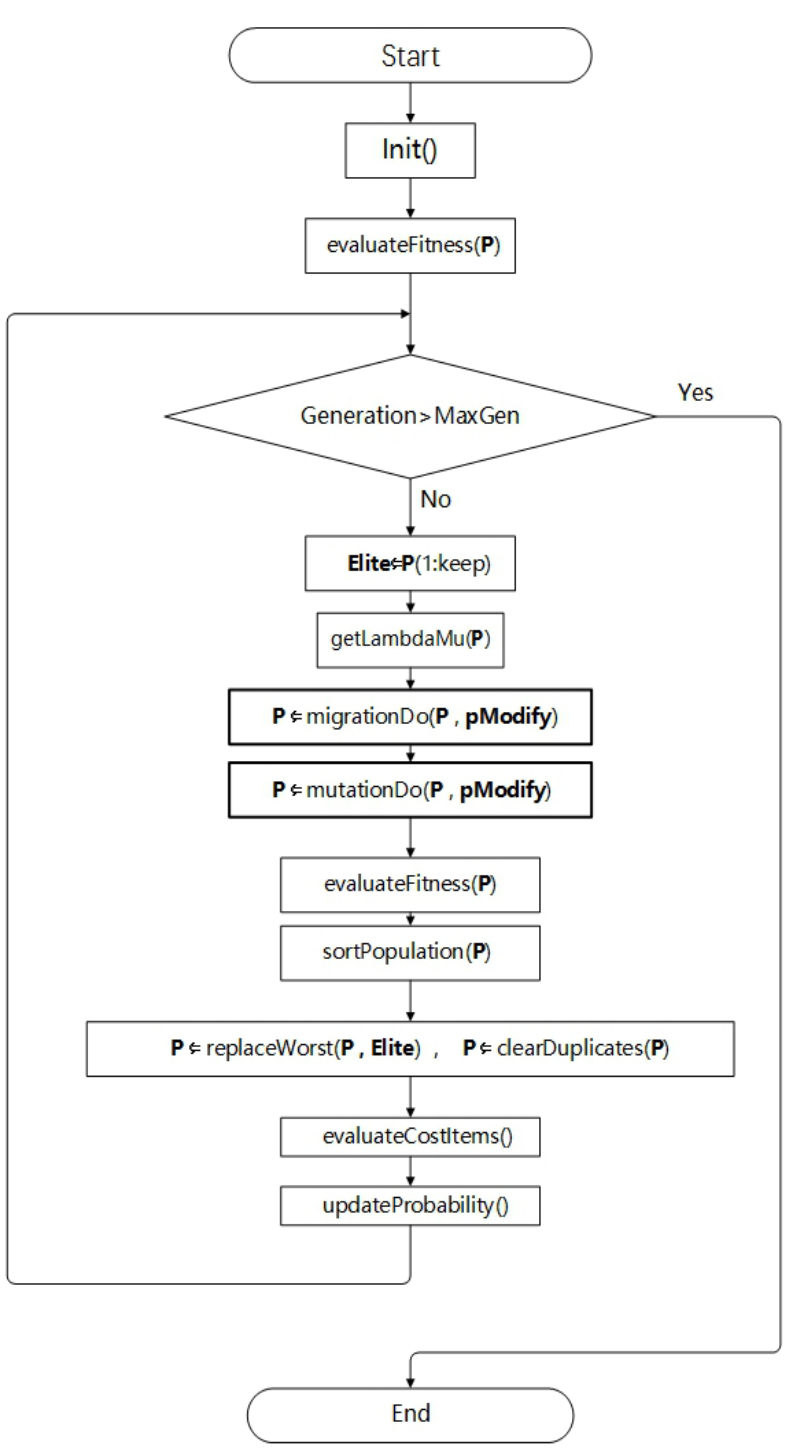
Figure 1. The procedure chat of the ε BBO